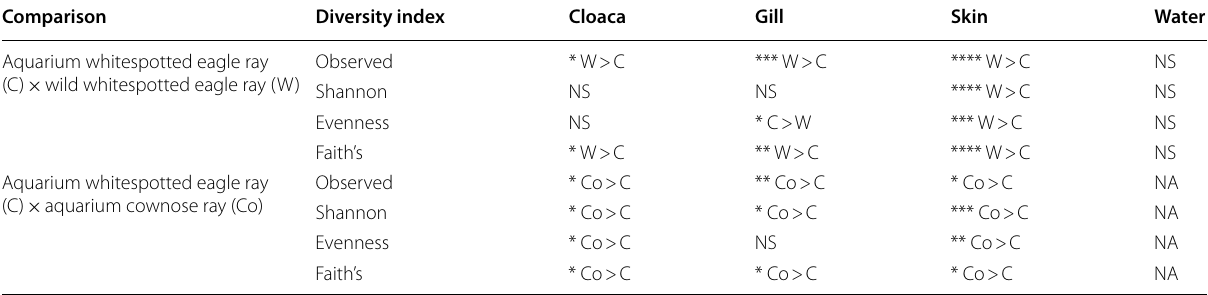
Table 2 Pairwise results for a one‑way analysis of variance (Kruskal–Wallis) for all α‑diversity metrics between aquarium cownose ( Rhinoptera bonasus ) and aquarium and wild whitespotted eagle rays ( Aetobatus narinari ) for different body